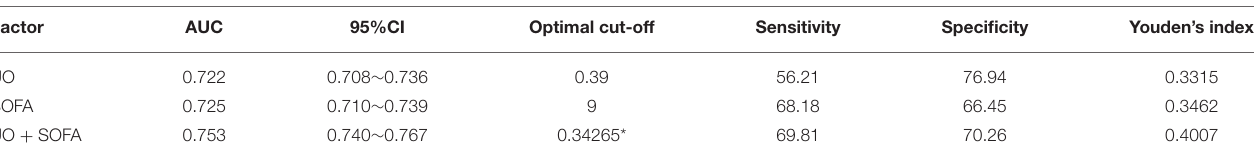
TABLE 4 | Comparison of ROC curves (before PSM).